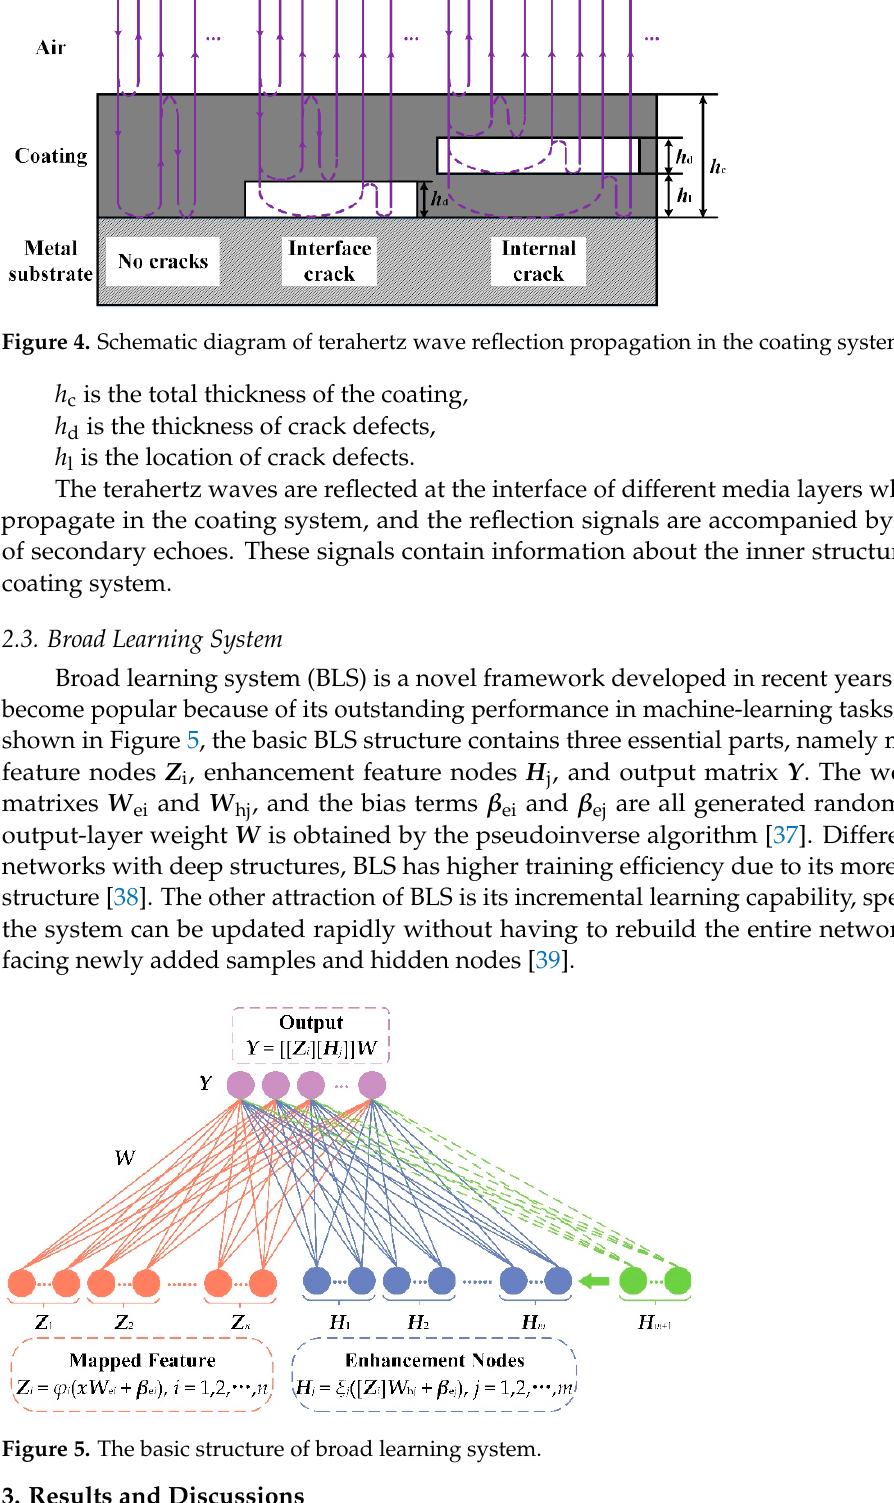
Figure 5. The basic structure of broad learning system.